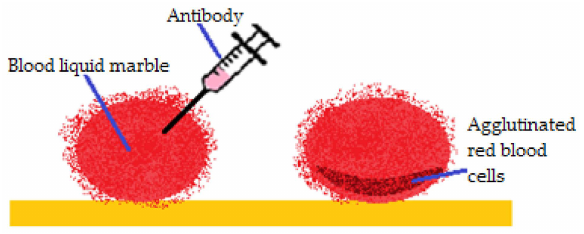
Figure 17. Haemagglutination reaction inside a blood liquid marble.